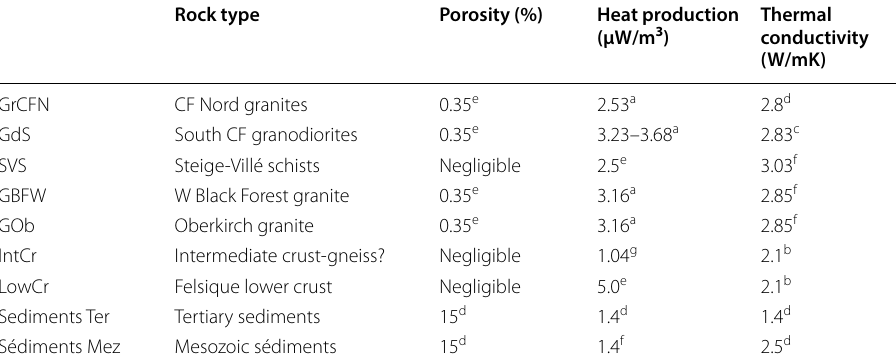
Table 1 Petrophysical parameters used for modelling of the